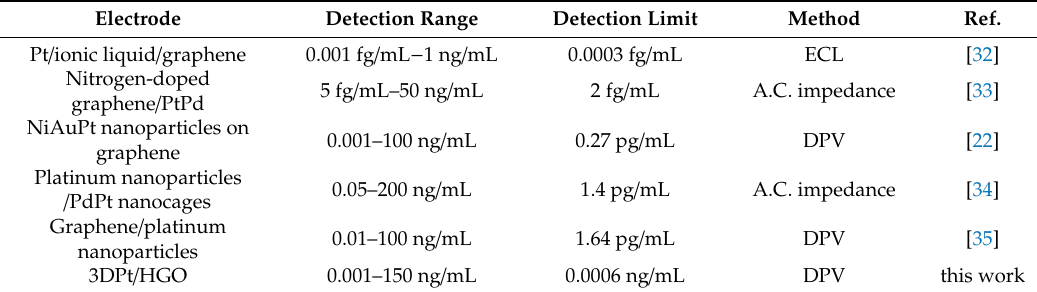
Table 1. Comparison of the response characteristics of di ff erent modified electrodes.